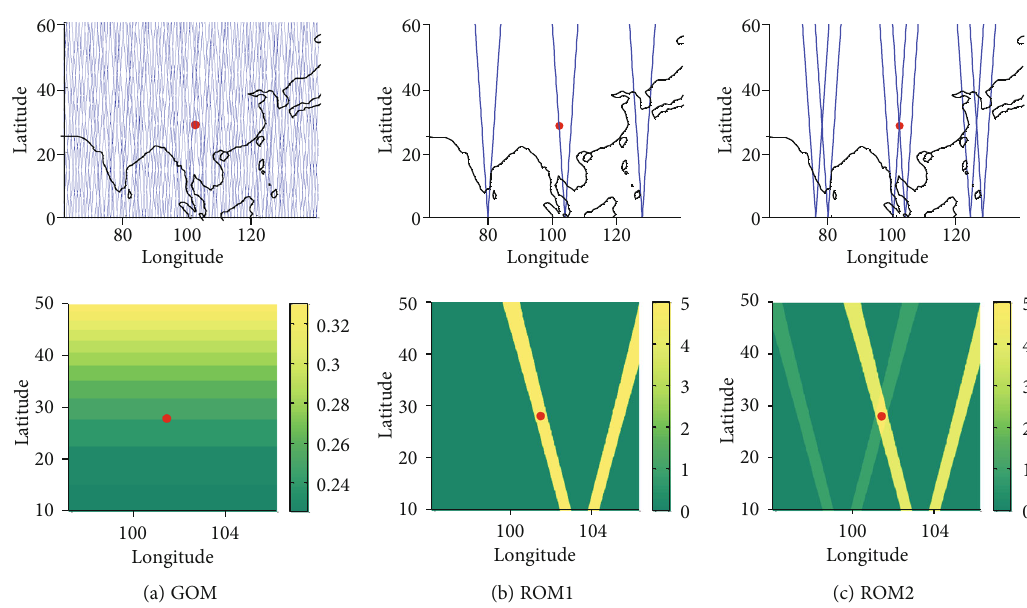
Figure 11: Ground tracks and average observation numbers per day of di ff erent constellations.